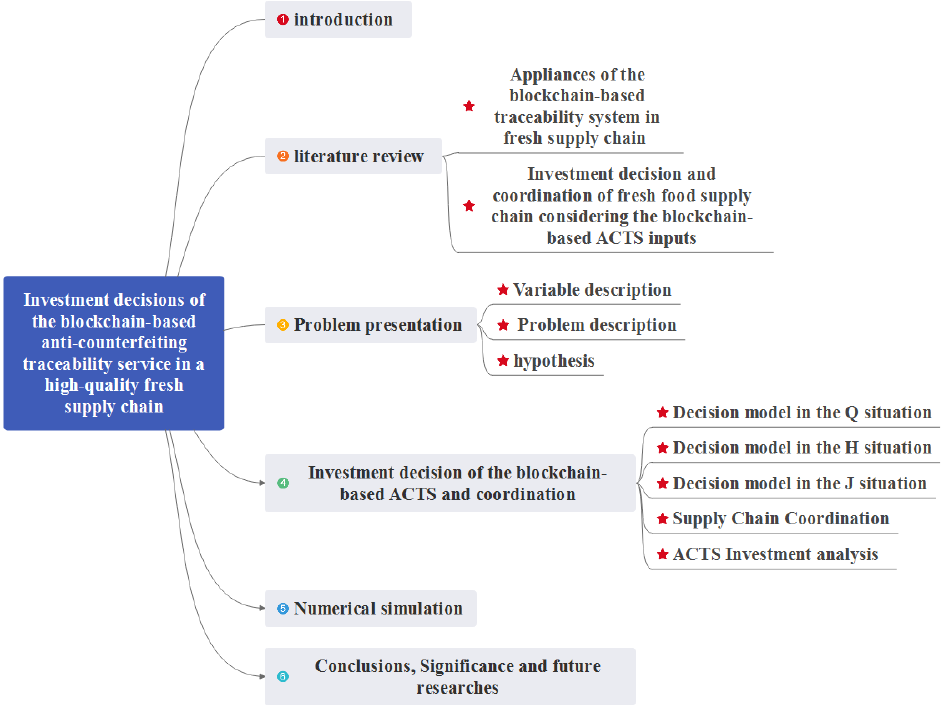
Figure 1. Research framework.